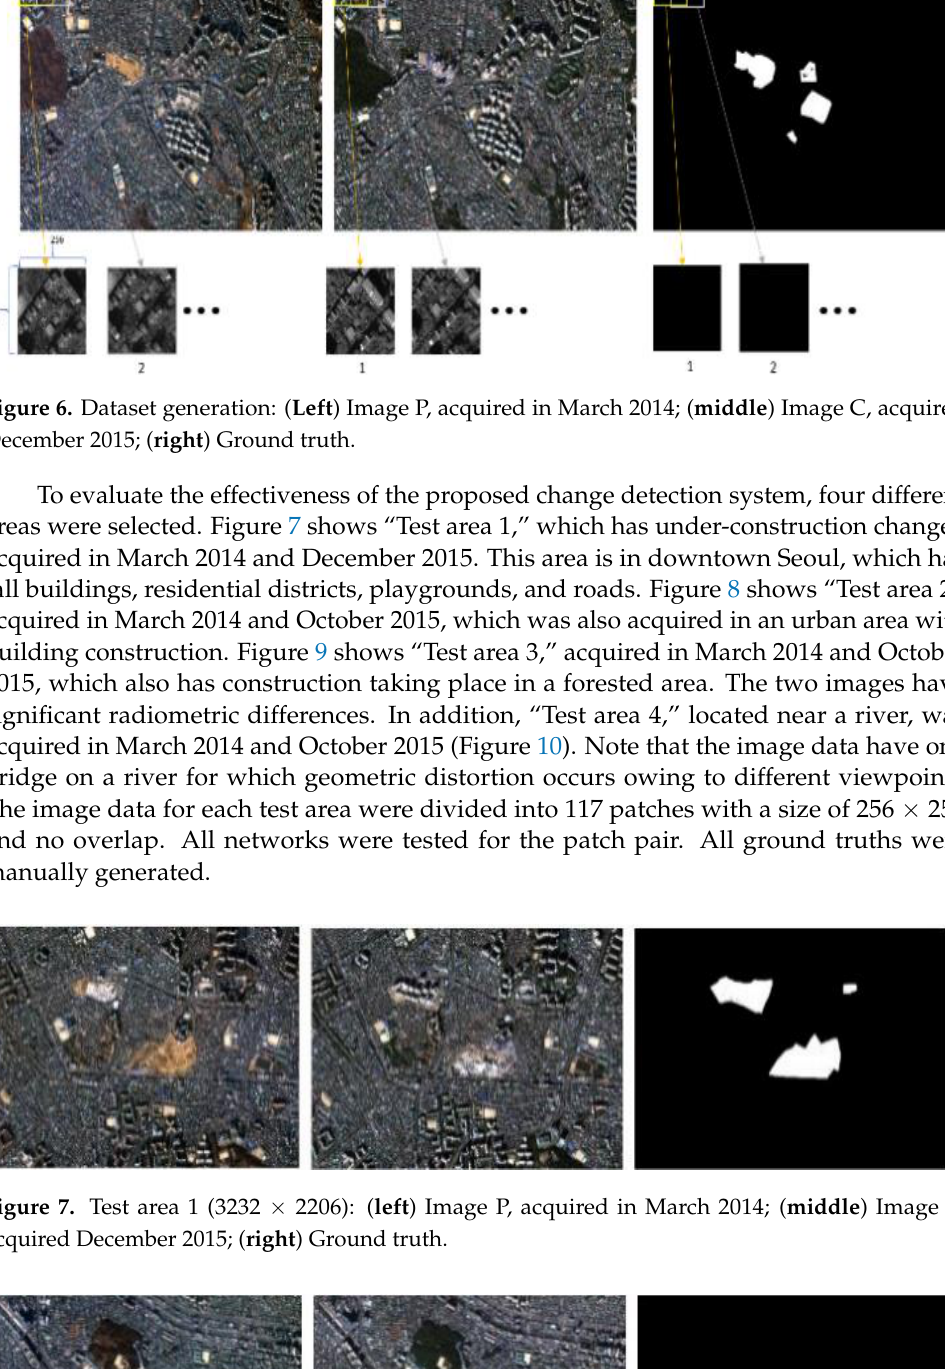
Figure 7. Test area 1 (3232 × 2206): ( left ) Image P, acquired in March 2014; ( middle ) Image C, acquired December 2015; ( right ) Ground truth.